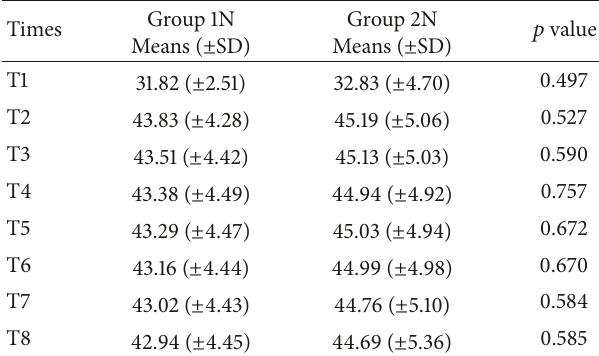
Table 3: Comparison of maximum interincisal distance (MID) (mm) according to the follow-up time between groups 1N and